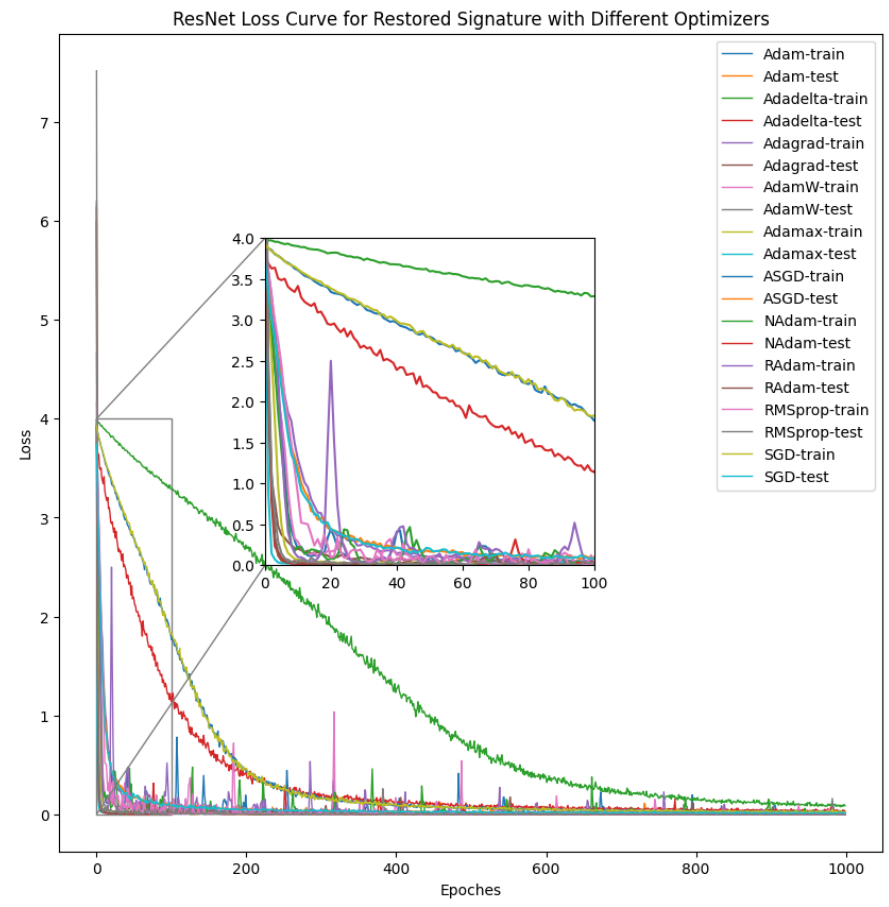
Figure 14. The loss curve of ResNet with respect to 10 different optimizers. Both the learning loss and testing loss for each optimizer are covered in the graph. The zoom-in area is ( x 1 , x 2 ) = (0, 100), ( y 1 , y 2 ) = (0, 4).